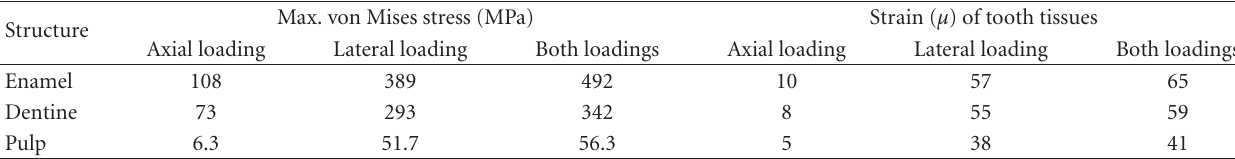
Table 2: Maximum von Mises stresses and strains sustained by tooth tissues under di ff erent occlusal loading scenarios. Structure